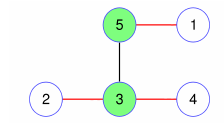
Figure 2: The graph of Figure 2 under cyclic